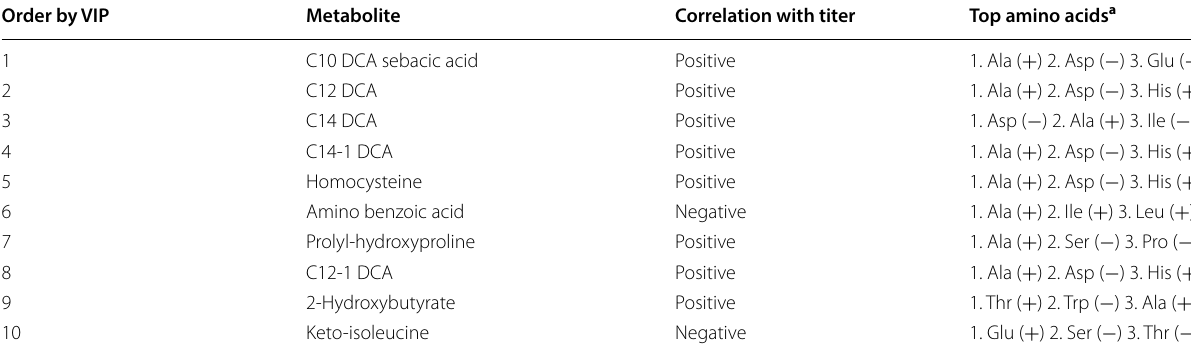
a The sign next to each amino acid indicates the correlation that amino acid has with the given metabolite (i.e., a “ correlation or promoter-like behavior with the given metabolite